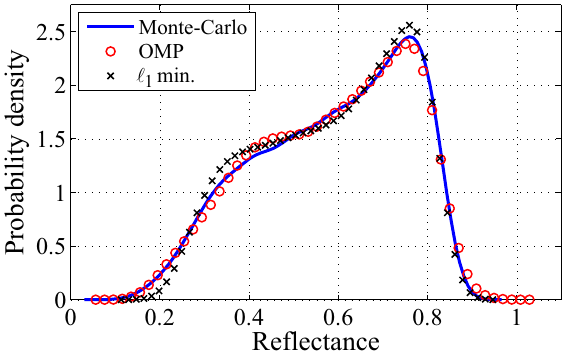
Figure 4: Probability-density function of the reflectance at the wavelength of maximum variance (approximately 1 . 328 µ m).